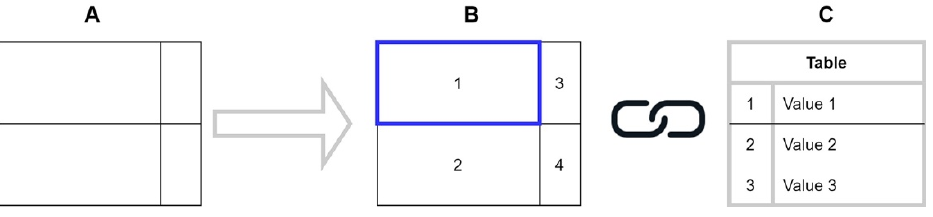
Figure 4. Base element extraction schema: A – vector wireframe; B – identification of base ele- ment on wireframe and assign ID; C – joining base element with table in database by ID field.